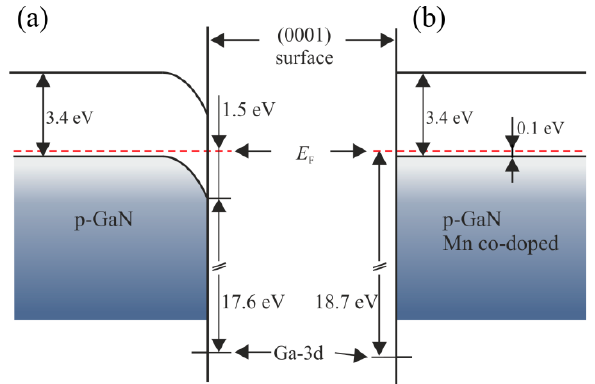
Figure 18. Band structure for ( a ) a pristine p ‐ GaN(0001) surface and ( b ) p ‐ GaN(0001) codoped with Mn, assuming that the bandgap does not change.